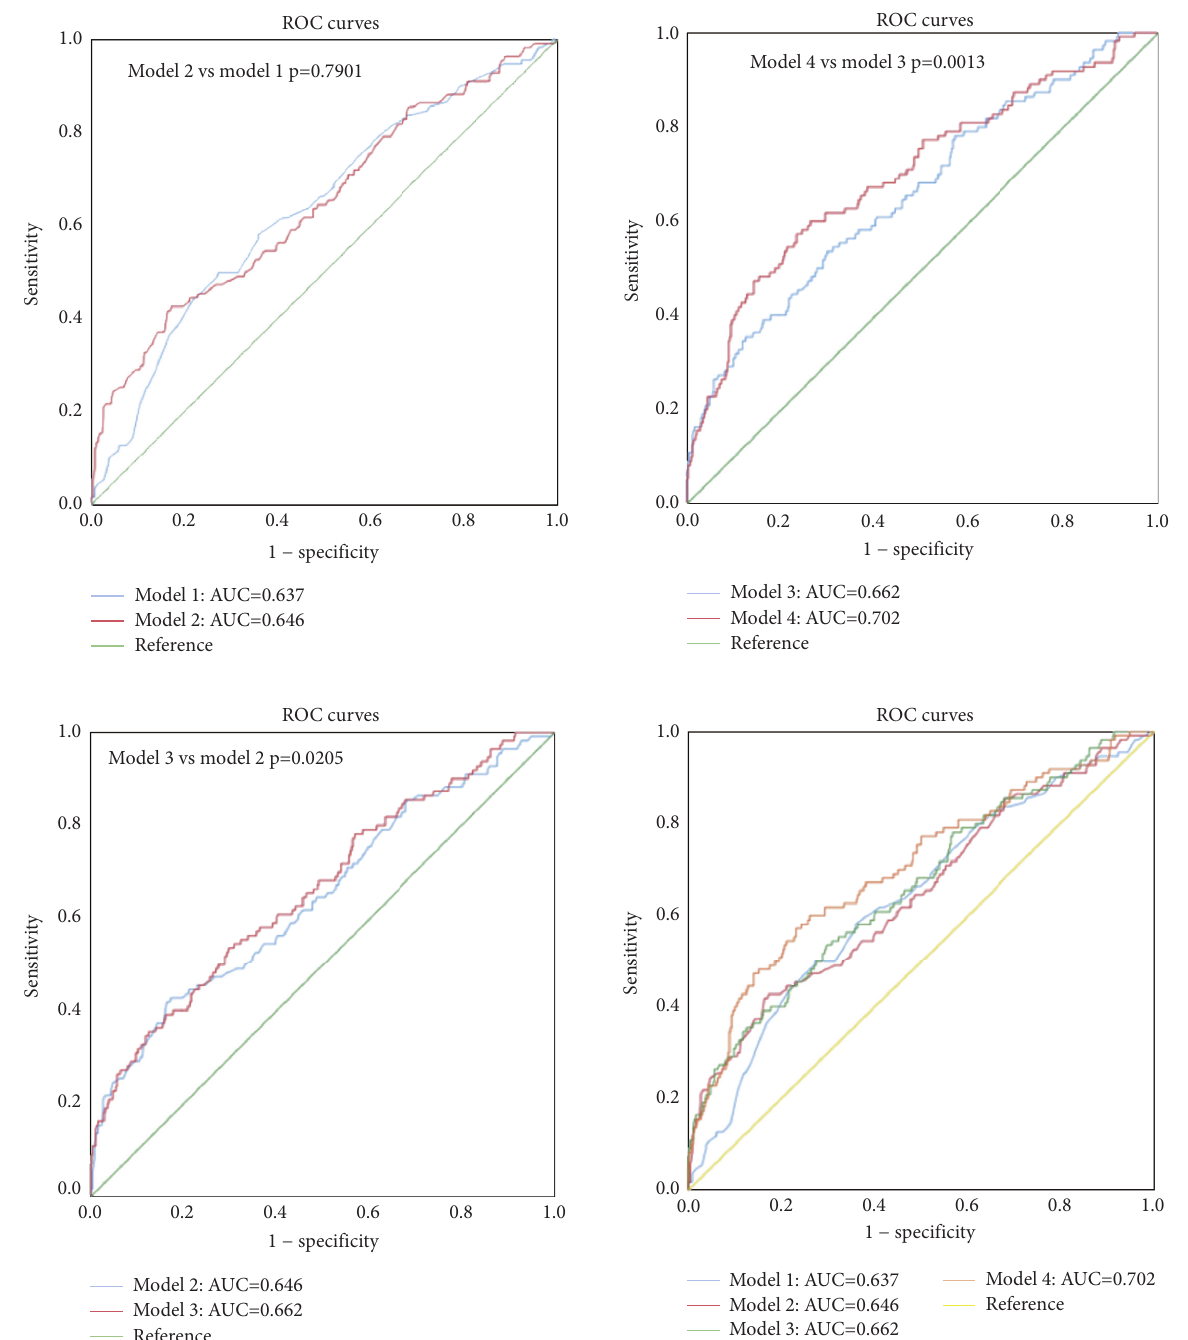
Figure 2: Area under the receiver operating characteristic curves for predicting prediabetes. Model 1: incorporating WC. Model 2: variables in model 1 and FHD. Model 3: variables in model 2 and HbA1c. Model 4: variables in model 3 and FPG. FHD: family history of diabetes; FPG: fasting plasma glucose; HbA1c: hemoglobin A1c; WC: waist